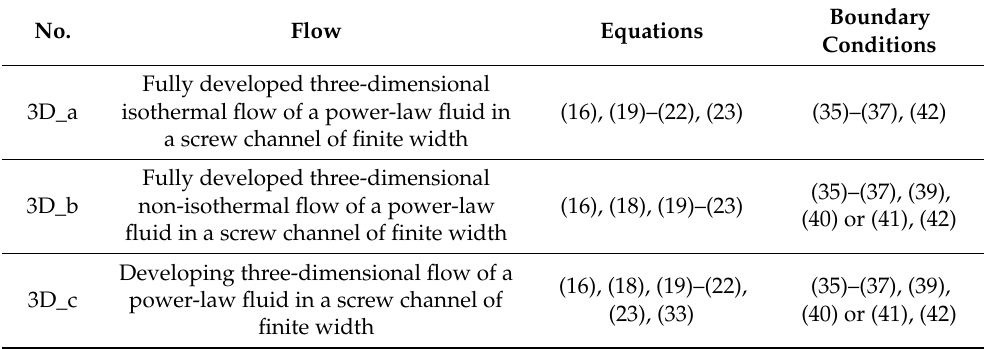
Table 4. Mathematical models of a three-dimensional flow of a power-law fluid in a screw channel of finite